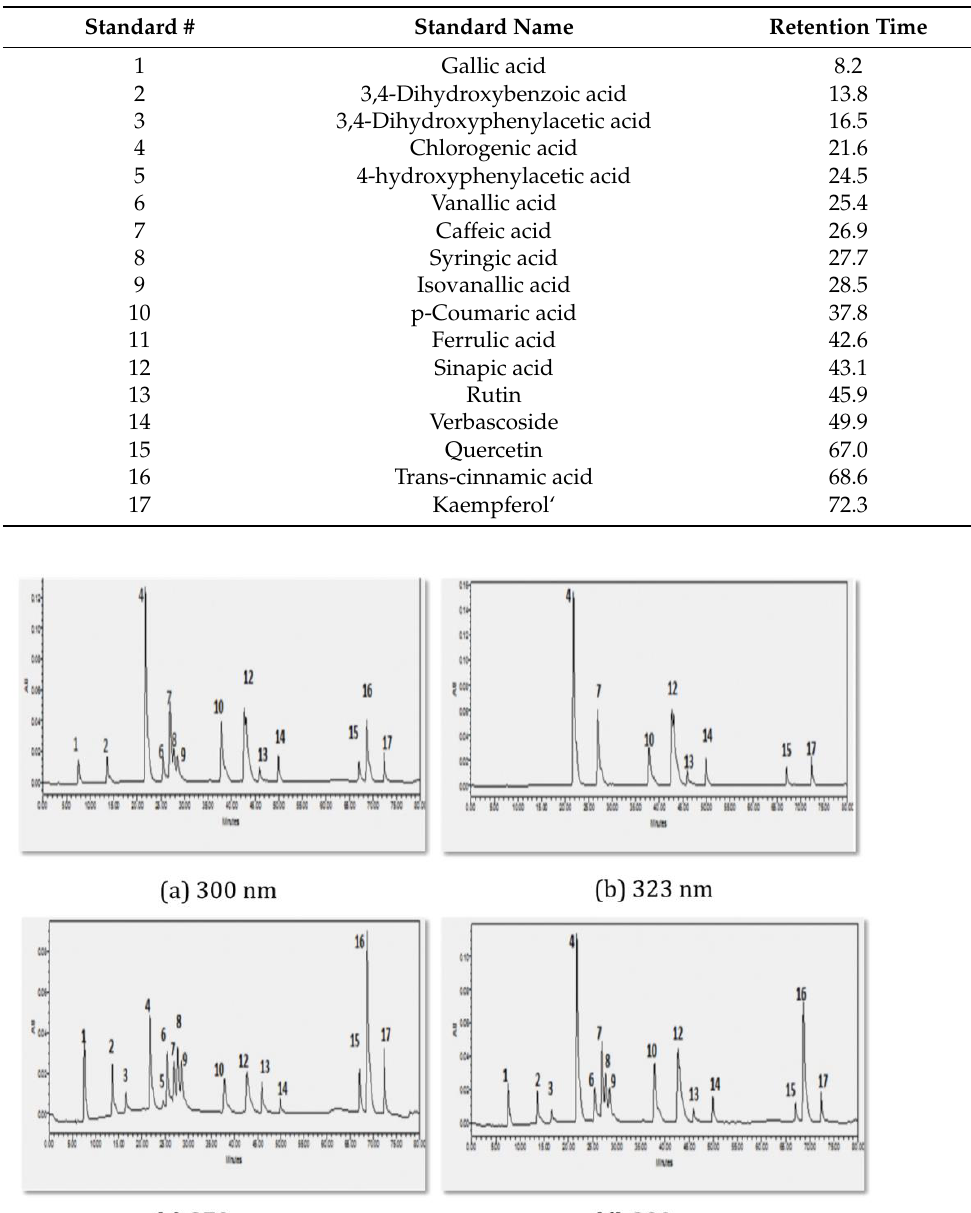
Table 2. HPLC retention times for selected standard compounds.